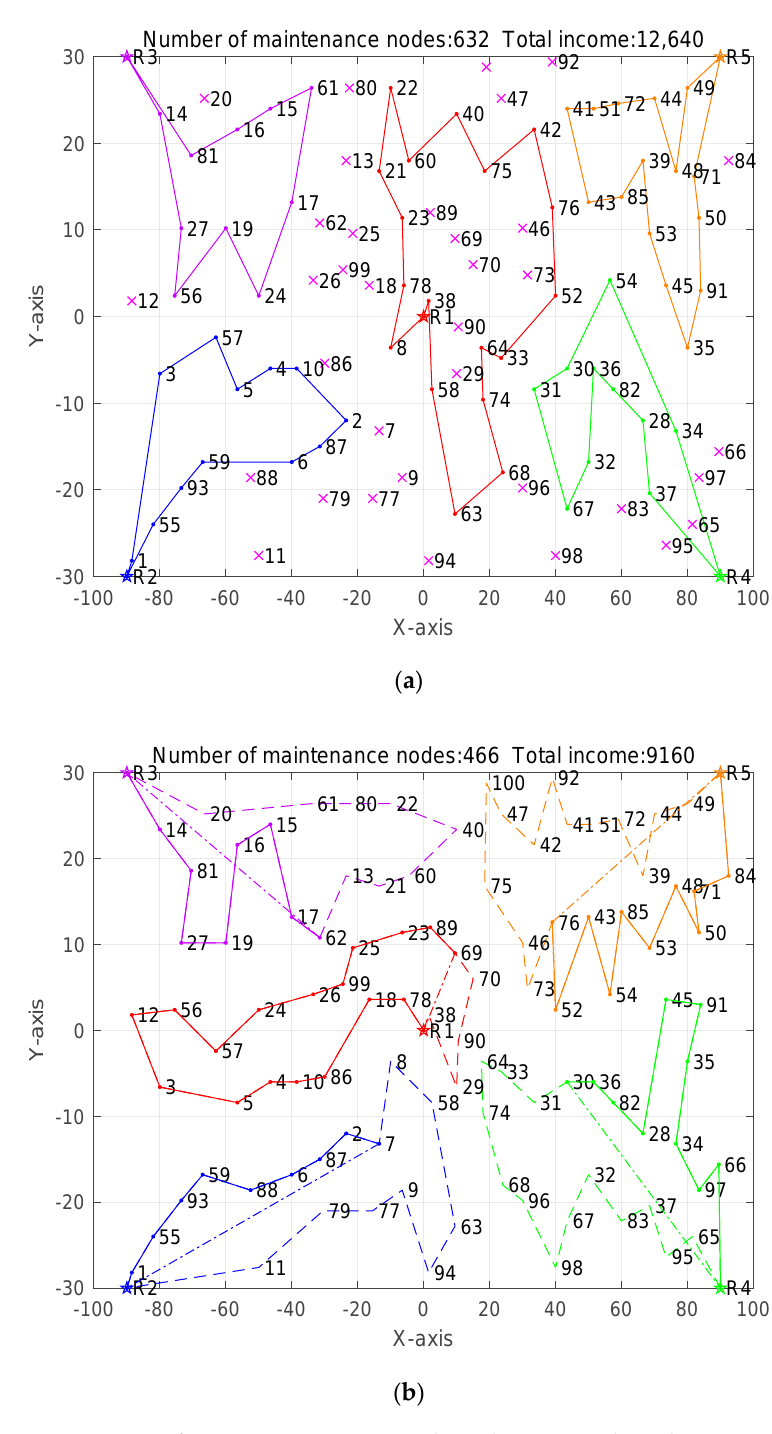
Figure 4. Comparison of maintenance routes when the space-robot cluster energy is 6000. ( a ) Optimal-path model; ( b ) shortest-path model.